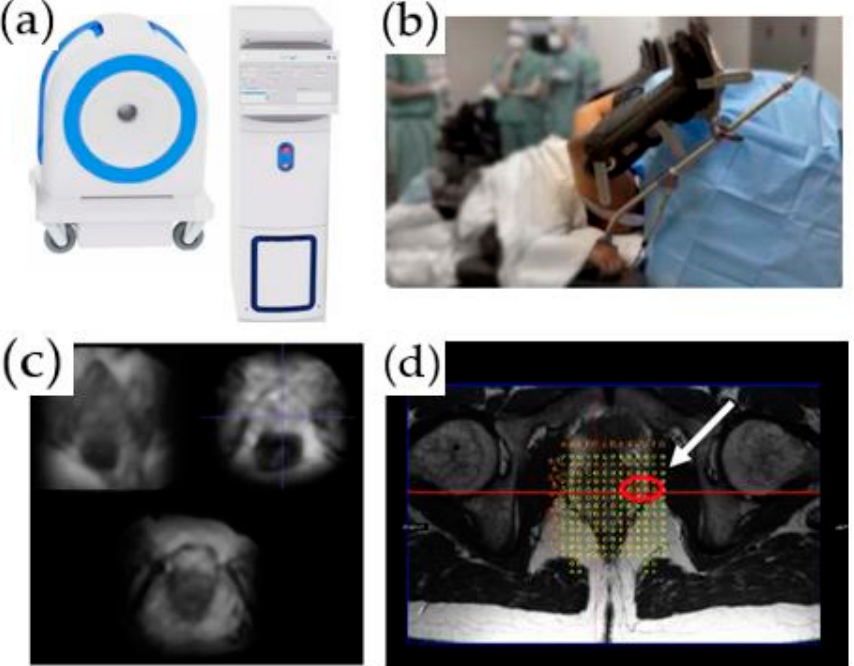
Figure 2. An office-based, low-field MRI system for prostate biopsy: ( a ) low-field MRI device; ( b ) biopsy device; ( c ) axial T2-weighted images acquired on the low-field magnet; ( d ) registered high-resolution axial T2-weighted image and grid for biopsy planning. A target is identified in the left lateral prostate (white arrow).